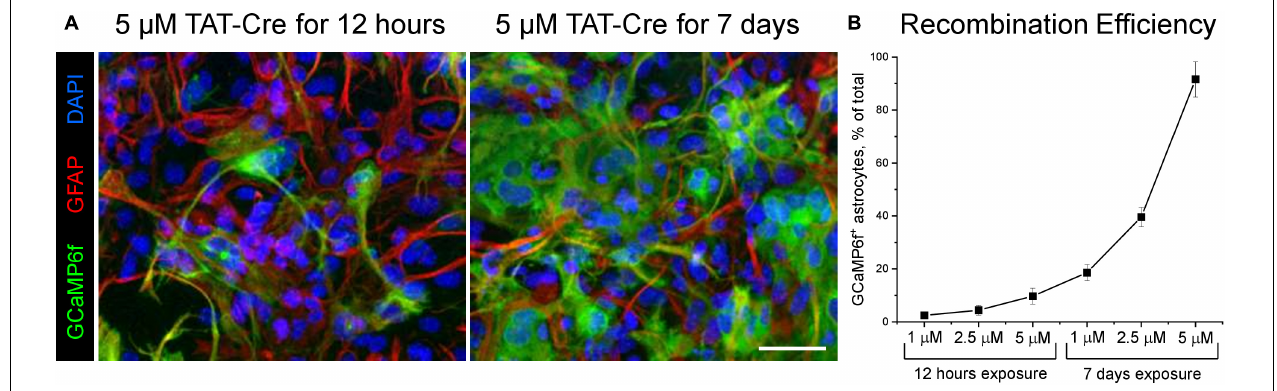
FIGURE 1 | TAT-Cre recombinase enzyme induces robust GCaMP6f expression in astrocytic cultures prepared from the cortices of Rosa-CAG-LSL-GCaMP6f mice. (A) Immunocytochemical labelling shows GCaMP6f (green) and GFAP (red) expression in astrocytes treated with 5 µ M TAT-Cre for 12 h or for 7 days. Nuclei were counterstained with DAPI. Scale bar, 50 µ m. (B) Efficiency of genetic recombination induced by 12 h or 7 days of exposure to 1, 2.5, and 5 µ M TAT-Cre was quantified as percentage of astrocytes expressing GCaMP6f. Connected squares show means ± SD, n = 3.